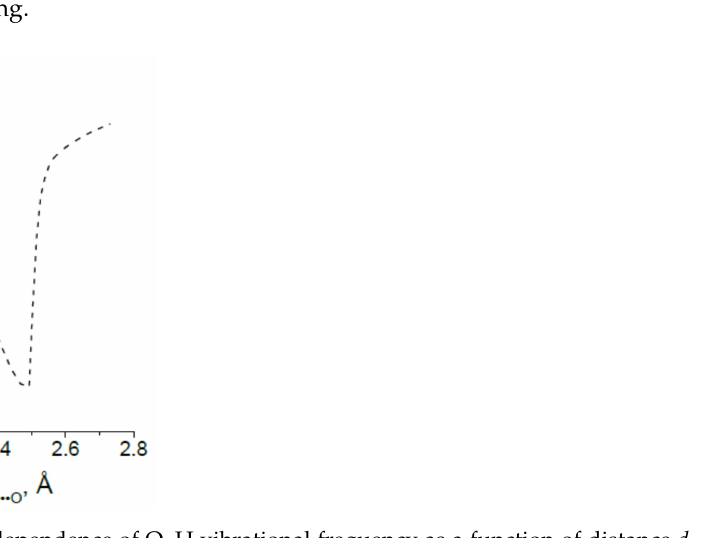
Figure 9. Assumed dependence of O–H vibrational frequency as a function of distance d O ··· O for O − H ··· O hydrogen